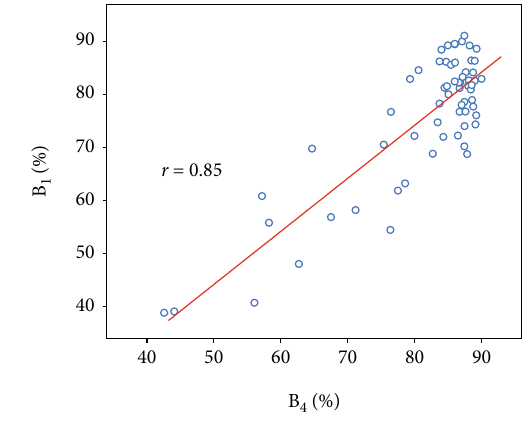
Figure 6: Linear relation between B